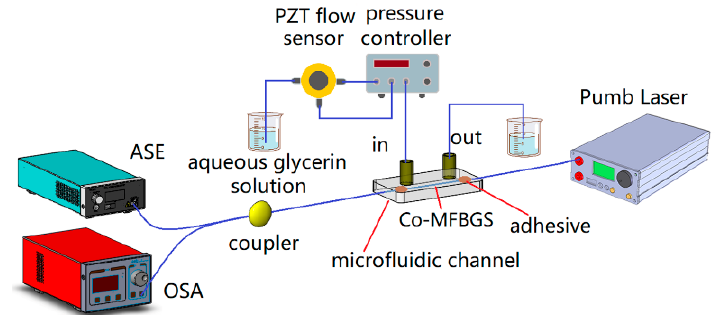
Figure 2. The experimental setup schematic of the presented